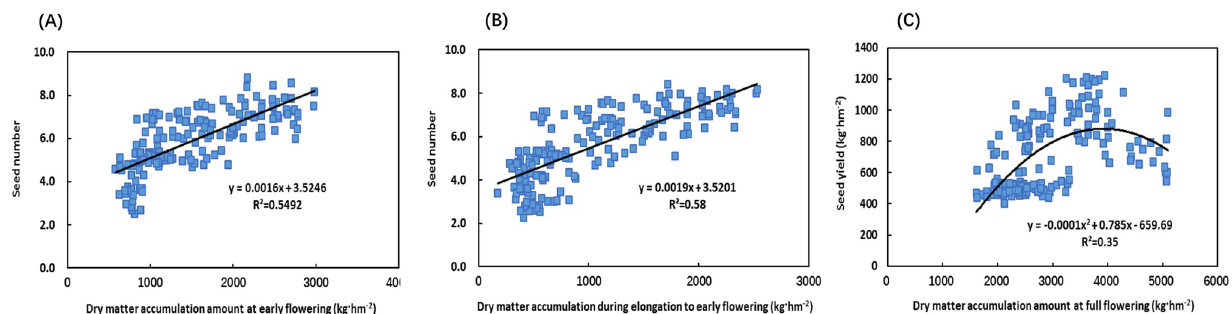
Fig 2. Relationships of dry matter accumulation with seed number and seed yield. Relationship between seed number and dry matter accumulation amount (dry matter accumulation amount at early flowering or elongation to early flowering, in experiments 1 and 2; n = 180, A and B, respectively) and the relationship between seed yield and dry matter accumulation amount at full flowering (in experiments 1 and 2; n = 180, C) of Chinese milk vetch.